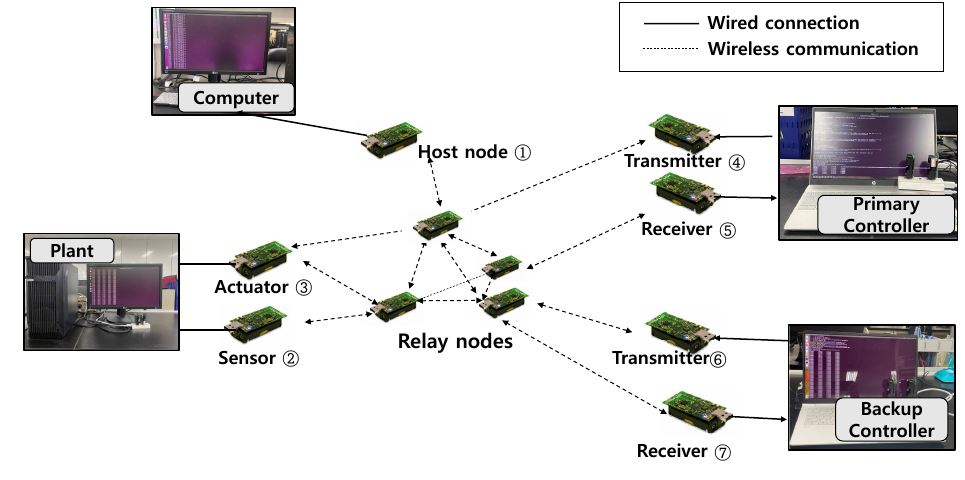
Figure 9. Experimental